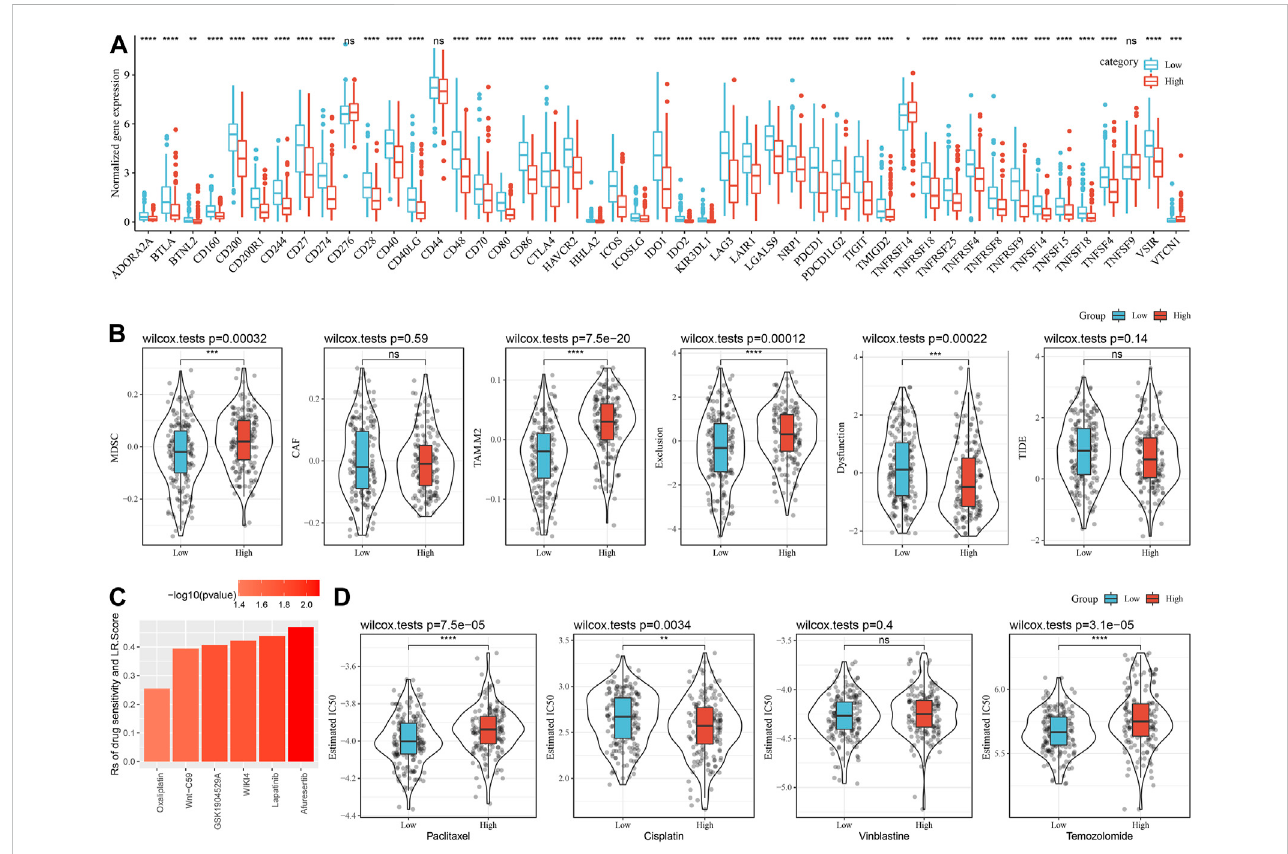
FIGURE 10 Differences between LR.score model and immunotherapy/chemotherapy. (A) Expression of immune expression points between LR.score groups in TCGA-SKCMcohort. (B) TIDEanalysisresultsbetweenLR.scoregroupsinTCGA-SKCMcohort. (C) LR.scorescoreandCorrelationofdrugresponsesintumor cell lines. (D) The box plots of the estimated IC50 for Paclitaxel, Cisplatin, Vinblastine and Temozolomide in